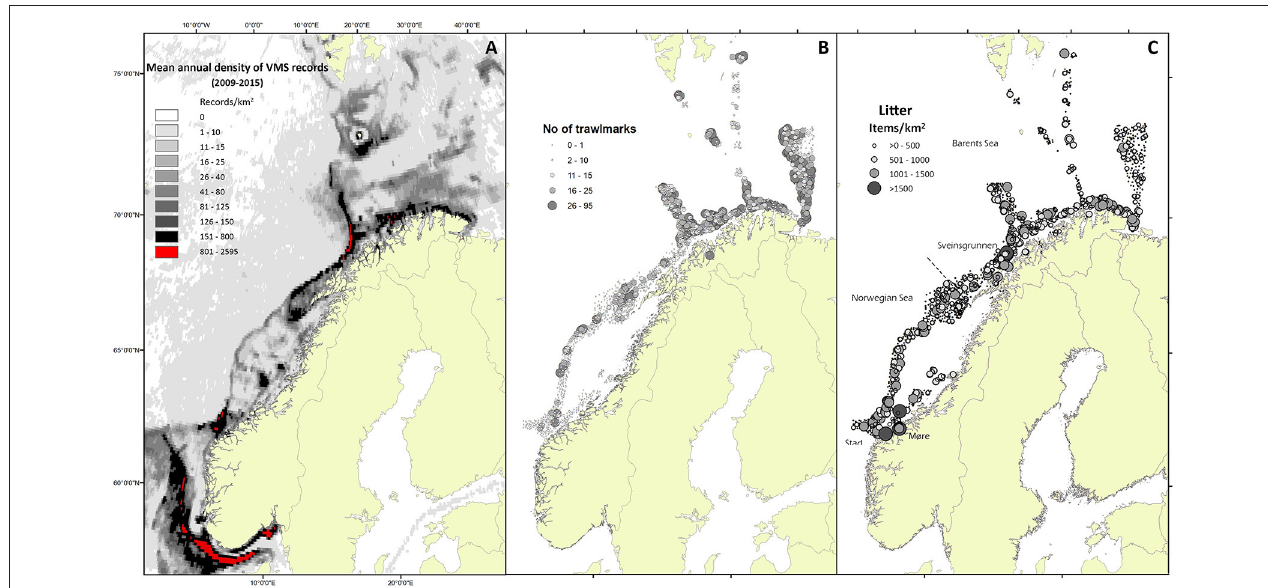
FIGURE 1 | Overview of indicators of human pressure (A) and impact (B,C) on the seabed. (A) Annual mean density of VMS records (pings) based on aggregated data for the period 2009–2015. (B) Number of trawlmarks observed during visual inspections part of the Mareano mapping programme. (C) Density of seabed litter observed during visual inspections